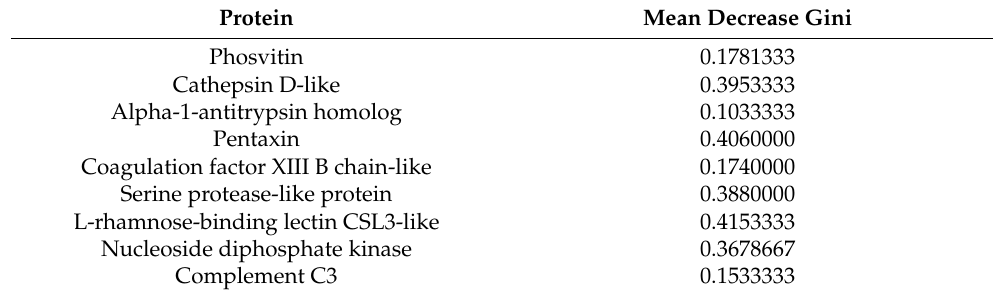
Table 5. The importance of classifiers according to the “random forest” algorithm of the machine learning.